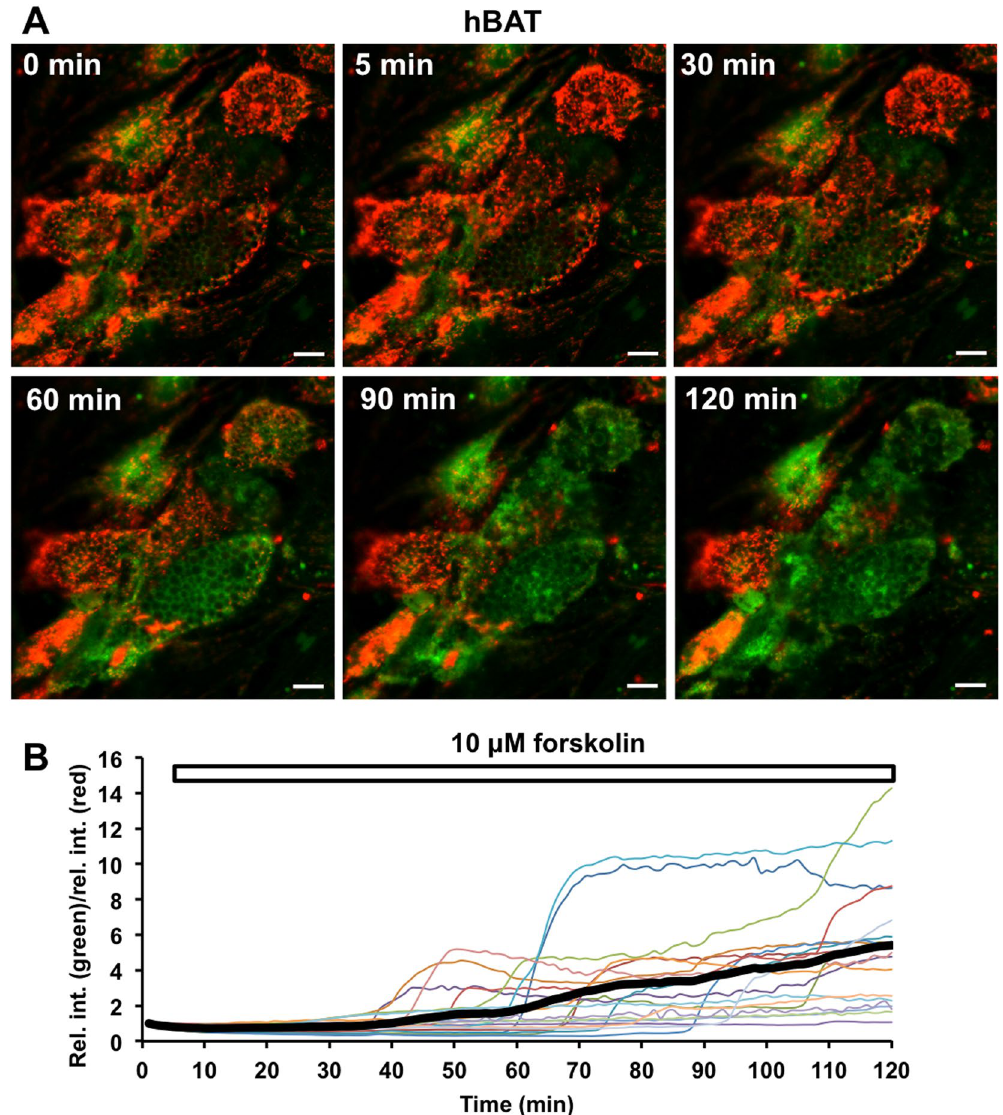
Figure 6. Forskolin stimulation induces mitochondrial depolarisation in human brown adipocytes. ( A ) In human brown adipocytes (BAs), red signal (JC-1 aggregates) corresponding to polarised mitochondria disappears and the intensity of green signal (JC-1 monomers) increases after forskolin stimulation, indicating depolarisation. For time-lapse video, see Supplementary Video 6. Scale bar: 20 μ m. ( B ) The relative intensity ratio of green and red signals is rapidly altered following forskolin stimulation in human BAs, indicating mitochondrial depolarisation. These sudden changes occur at different time points in individual cells. The thick black curve represents the average relative intensity ratio of green to red signals in all imaged cells, including responding and non-responding